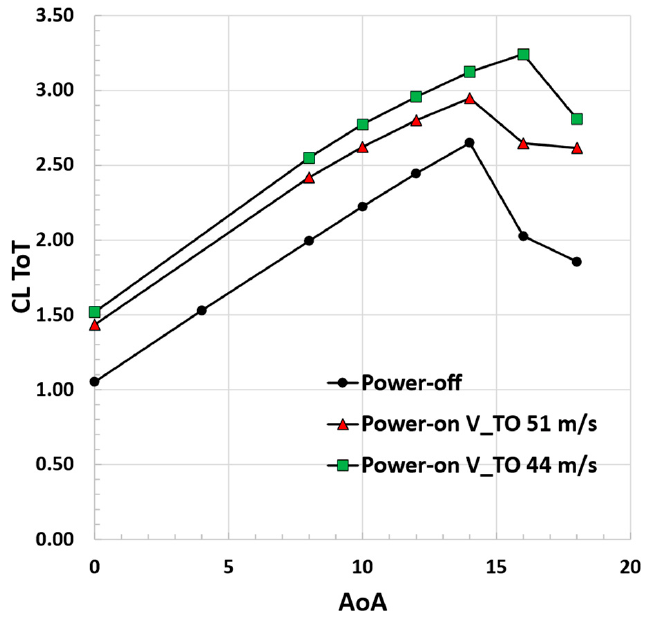
Figure 24. Total lift coefficient curves for power-off and power-on take-off conditions, V TO = 44 m/s and V TO = 51 m/s, Re = 5.7 × 10 6 , J TIP = 0.78, rpm TIP = 1600, J DEP = 0.89, rpm DEP = 2000. Table 17. Numerical results for take-off power-on condition, untrimmed maximum lift coefficient, mo- ment coefficient calculated w.r.t. CG pos. (31% mac), V TO = 44 m/s and V TO = 51 m/s, Re = 5.7 × 10 6